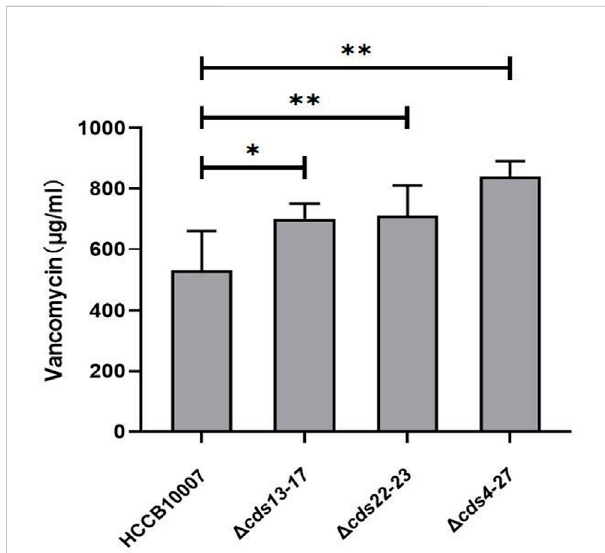
FIGURE 6 Improvement of vancomycin production. HPLC detection of vancomycin inthemutantsindicatedthattheyieldofvancomycin was increasedowingtothesuccessfuldeletionsofgeneclusters cds13-17 , cds22-23 , and cds4-27 in ECO-0501 BGC. The position indicated by the red arrow was ECO-0501 peak. Original, original strain A. keratiniphila HCCB10007; Δ eco-cds13-17 , the mutant A. keratiniphila HCCB10007 Δ eco-cds13-17 ; Δ eco-cds22-23 , the mutant A. keratiniphila HCCB10007 Δ eco-cds22-23 ; Δ eco-cds4-27 , the mutant A. keratiniphila HCCB10007 Δ eco-cds4-27 . Error bars represented the standard deviations from three independent biological replicates of each strain. * p < 0.05, ** p <